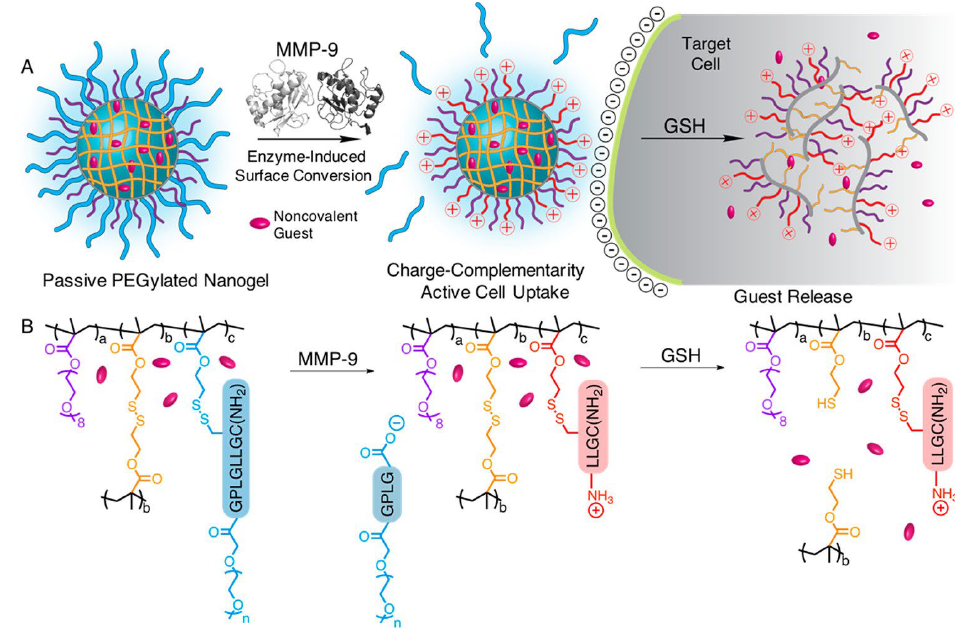
Figure 6. Schematic illustration of the structure of the enzyme-/redox-dual-sensitive PEGylated nanogels and their MMP-9-triggered intracellular drug release. Reprinted from with permission Ref. [118]; American Chemical Society. ( A ) Schematic illustration of the DePEGylation and intracel- lular drug release; ( B ) The chemical structure of the copolymer before and after being treated with MMP-9 and GSH.